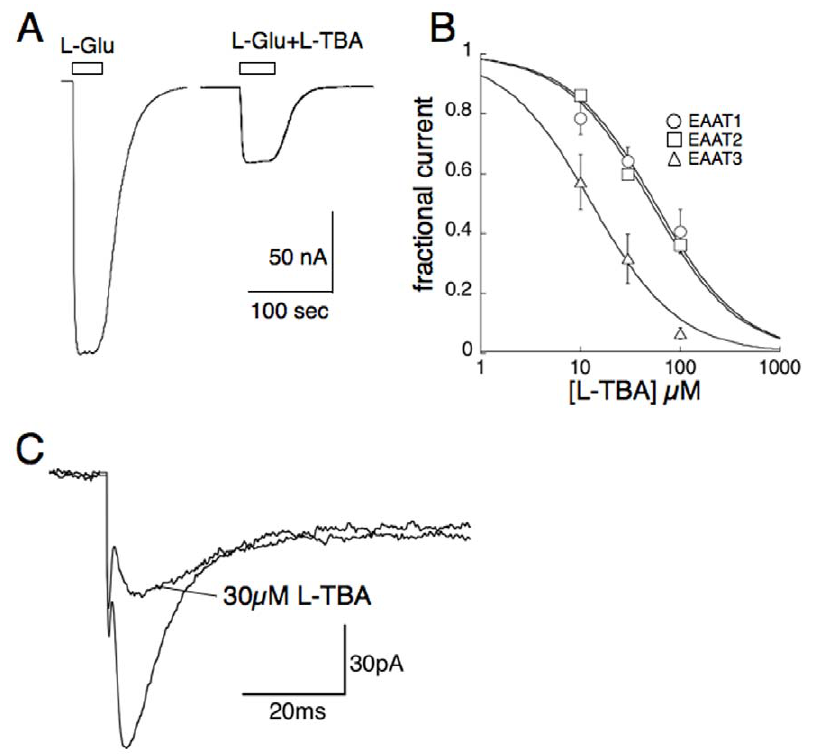
Figure 2. Effects of L-TBA on native and recombinant transporters. (A) Representative recording from voltage-clamped Xenopus oocyte expressing astrocyte transporter subtype EAAT2. 100 m M L-TBA partially blocks equimolar L-Glu uptake current mediated by EAAT2. (B) Summary of L-TBA concentration-dependence of block of 100 m M L-Glu currents in oocytes expressing EAAT1-3, showing approximately four-fold selectivity for EAAT3 by least-squares minimized fits to mean data generating IC 50 values of 56, 52, and 13 m M, respectively. (C) Effect of 30 m M L-TBA on synaptically activated transport current (STC) in hippocampal CA1 astrocyte. Currents in the presence or absence of L-TBA were evoked by stimulation in stratum radiatum in the continuous presence of ionotropic receptor antagonists (see methods). 30 m M L-TBA blocked 66.7 6 10.4 of the peak STC (n=4).